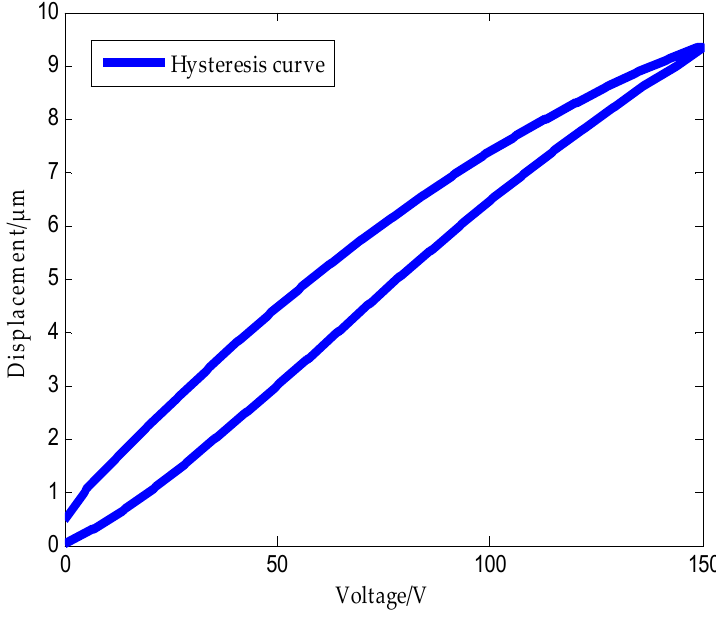
Figure 1. Hysteresis characteristic of a piezoelectric ceramic.